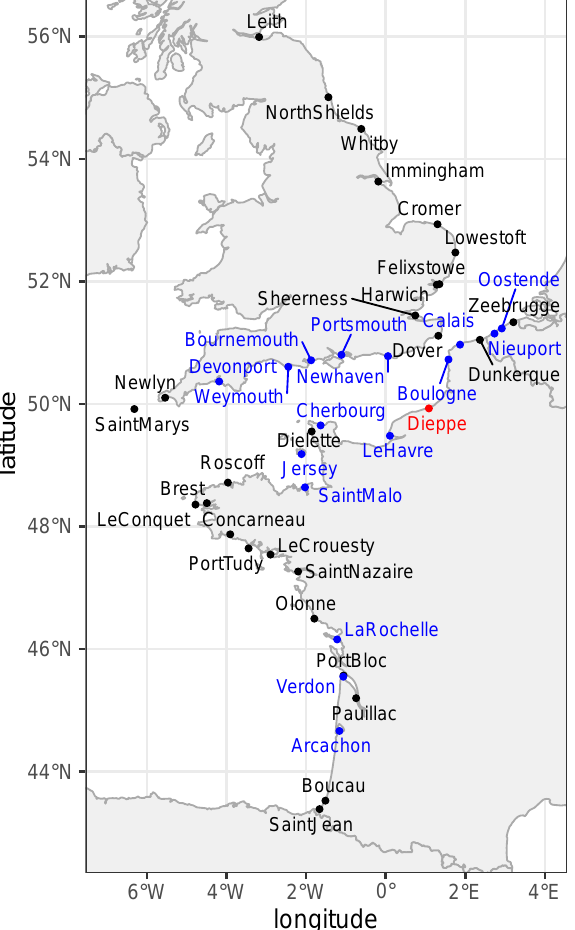
Figure 1. Extremogram region grouping the stations (blue dots) with at least 30% of extreme surge events in common with Dieppe (red dot). These stations are used for the imputation of Dieppe’s surge time series with a regionalization approach. Stations in black have fewer than 30% of events in common with Dieppe due to distance or different data